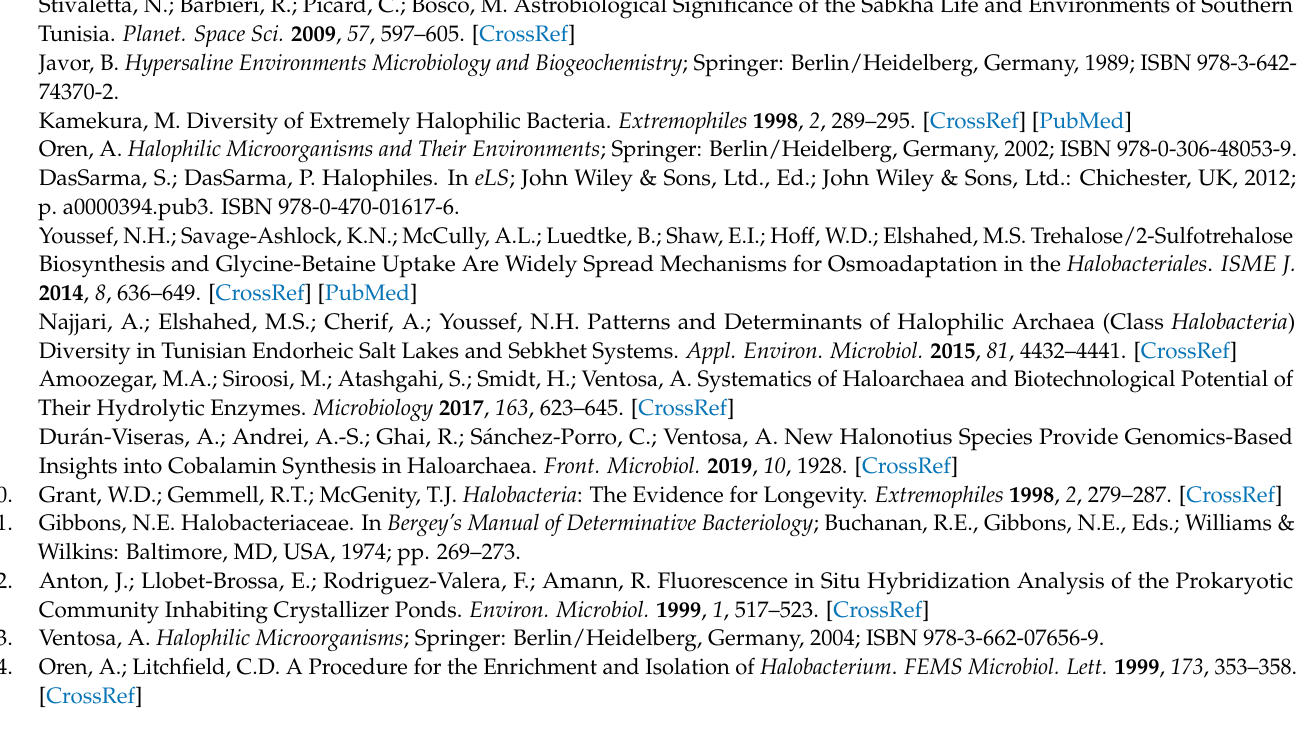
Table S1: Unique and shared genera between CDW, CDR and CDZ samples based on cultured, 16S rRNA libraries, DGGE and metataxonomic approaches, Table S2: List of shared and unique